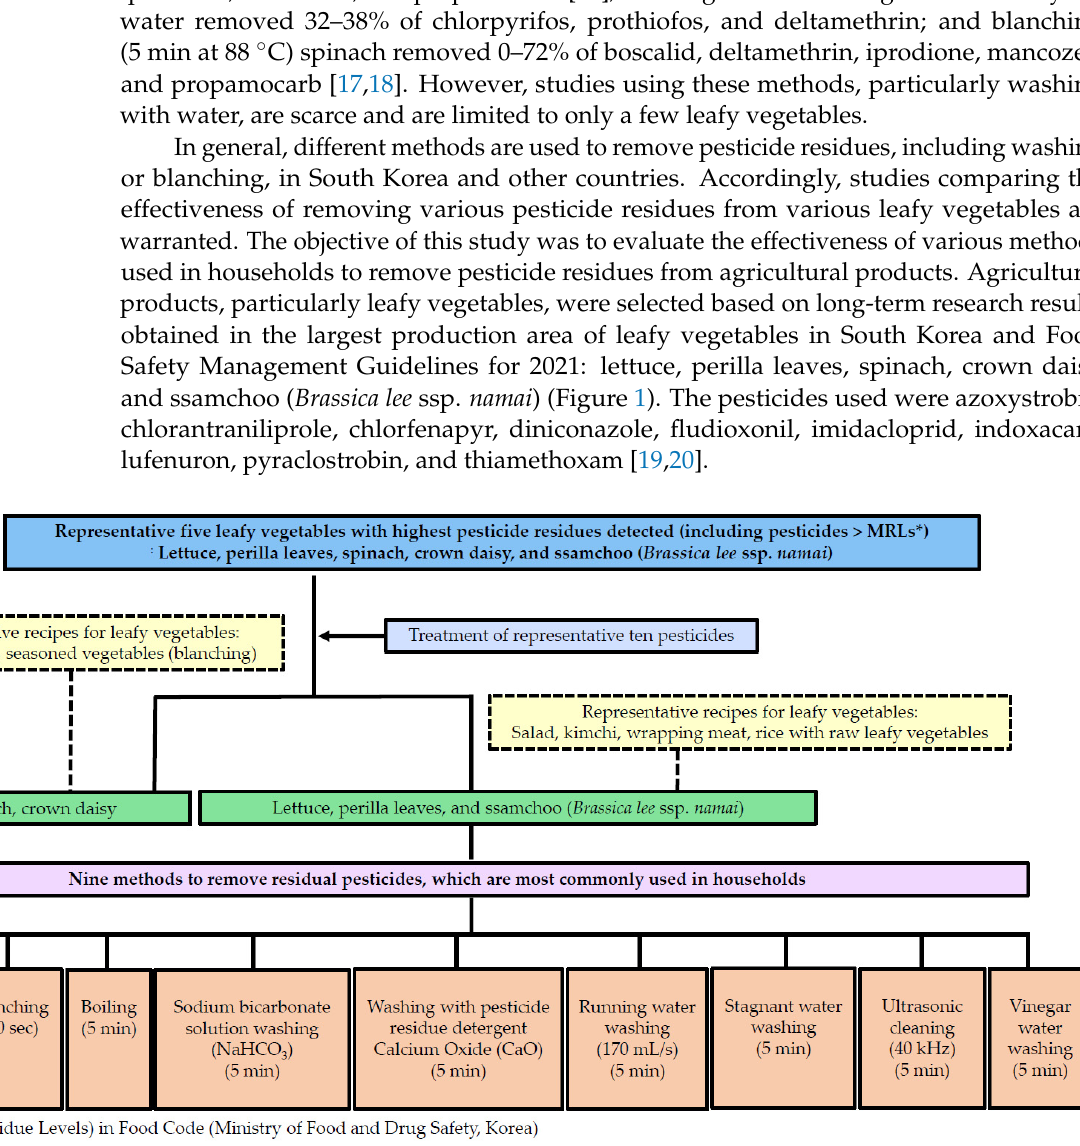
Figure 1. Sampling and processing scheme.